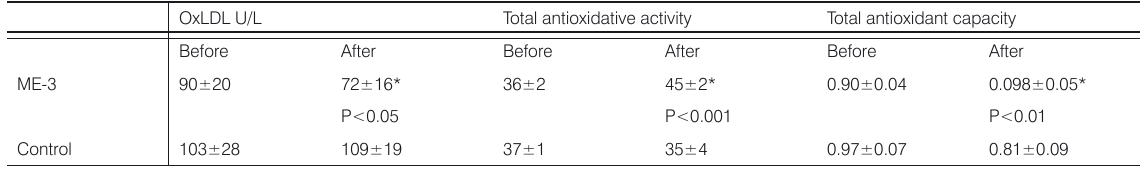
Table 2. Blood OxLDL levels and plasma total